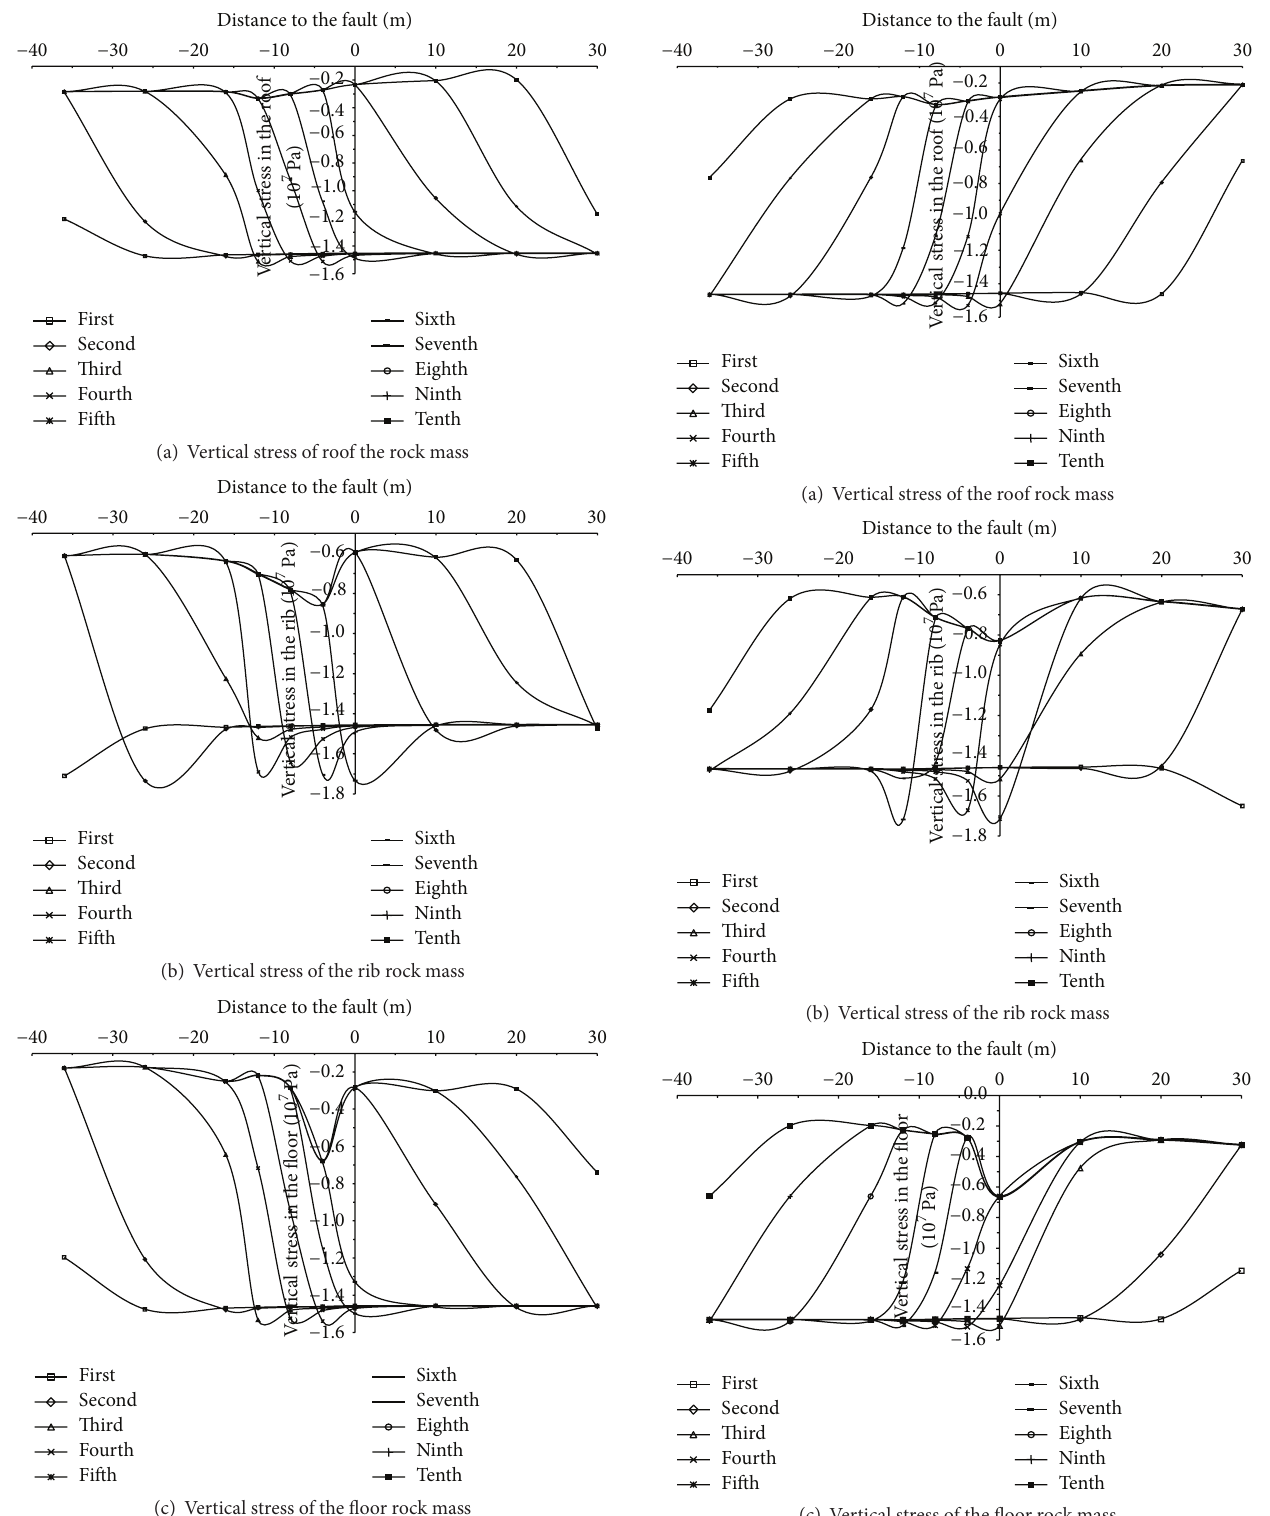
Figure 9: Vertical stress of the surrounding rocks when the roadway passes from the hanging wall to the foot wall of the fault. Note: first to tenth denotes the excavation sequence.